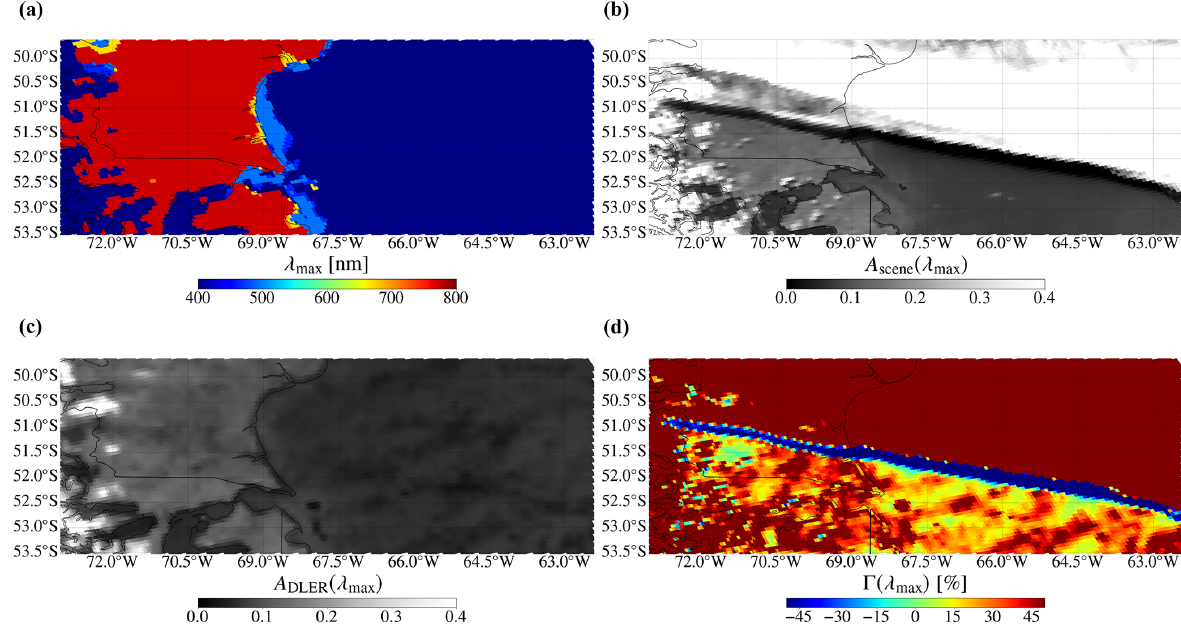
Figure 6. The wavelength at which DLER is maximum λ max (a) , the SCNLER at λ max (b) , the DLER at λ max (c) , and contrast parameter (cid:48) at λ max (d) , for southern Chile and Argentina on 3 August